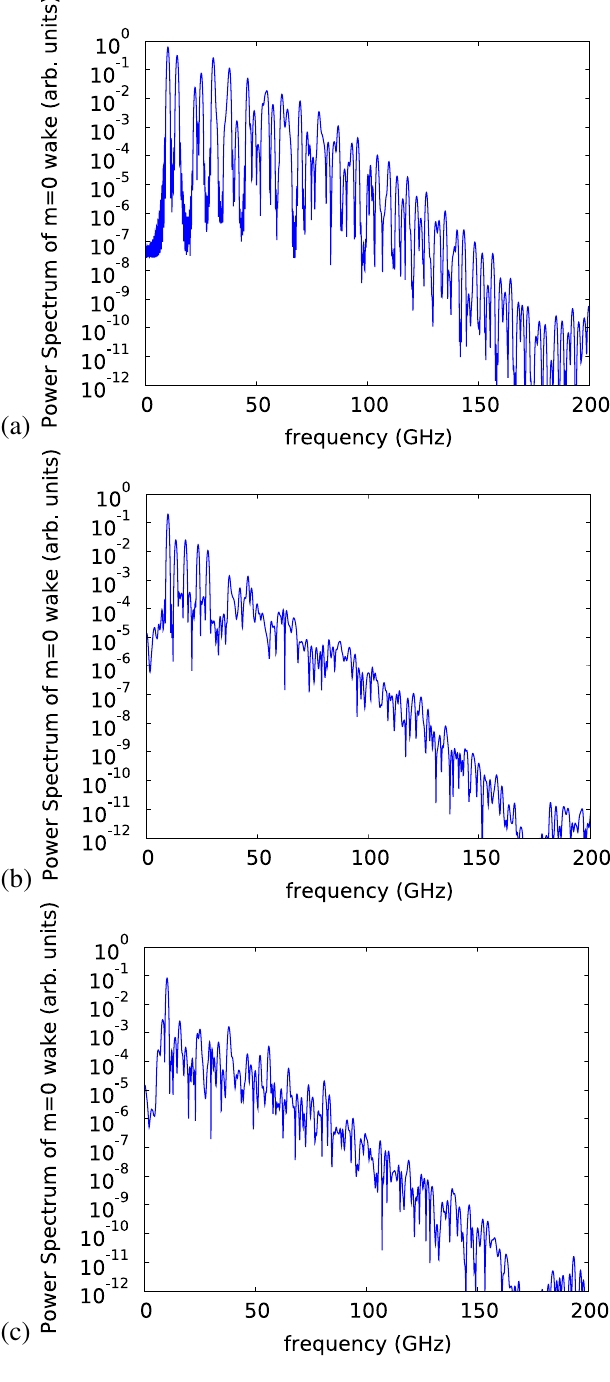
FIG. 6. (Color) Power spectra of the monopole wakes in the (a) closed pillbox cavity, (b) PhC cavity, and (c) optimized PhC